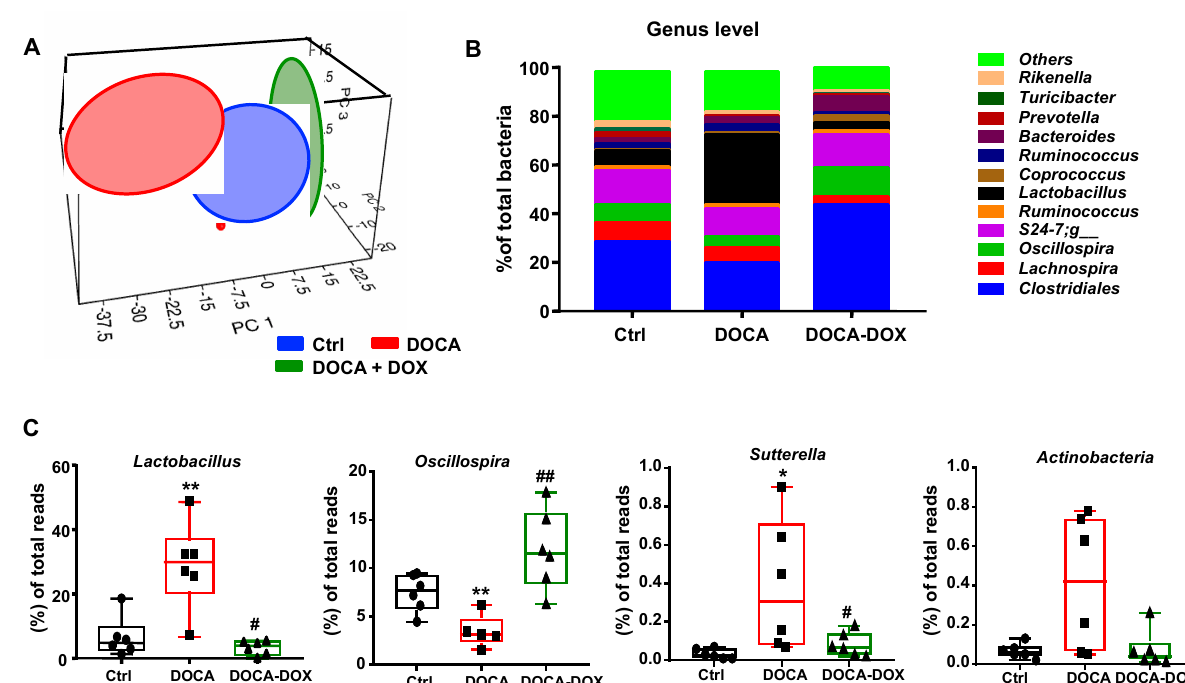
Figure 3. Effects of Doxycycline (DOX) on genera shifts in gut microbiota composition. ( A ) Principal components analysis for gut microbiota. ( B ) Main bacterial genera as percentages of total bacteria. DOXI resulted in distinct populations of bacteria at the genus level. ( C ) Bacterial genera Lactobacillus, Osciillospira, Suterella and Actinobacteria in the gut microbiota in control (Ctrl) and DOCA-salt rats. Data represented as means ± SEM ( n = 6). * p < 0.05, ** p < 0.01 versus the Ctrl group; # p < 0.05, ## p < 0.01 versus the untreated DOCA-salt group.